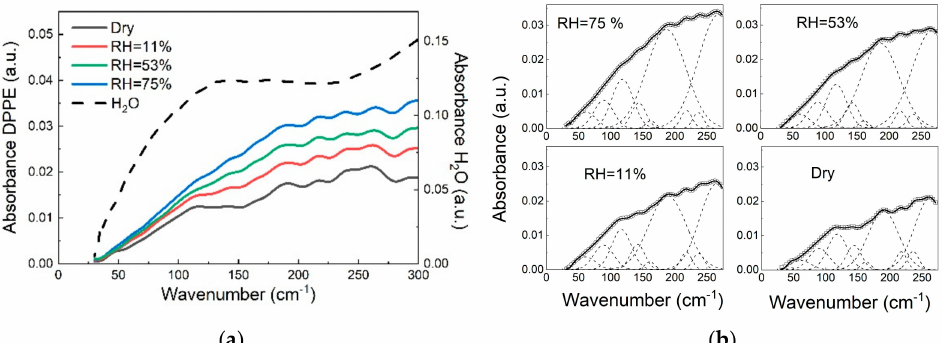
Figure 4. Far-infrared spectra of the DPPE/H 2 O samples. ( a ) Spectra of pure water (dashed line) and of the samples at four distinct hydration degrees: dry (black full line), RH = 11% (red), RH = 53% (green), and RH = 75% (blue); ( b ) The spectra of the dry sample and of the wet samples are shown separately with the corresponding fitting curve (solid black line) obtained as the sum of the individual Gaussian peaks (dashed black